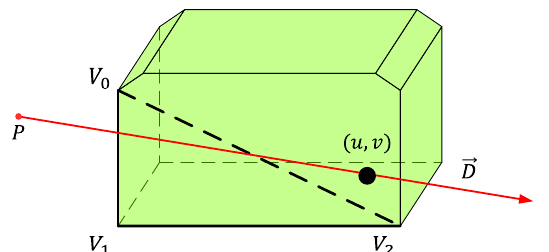
Figure 5. The intersection between a ray and a non-obstruction box.